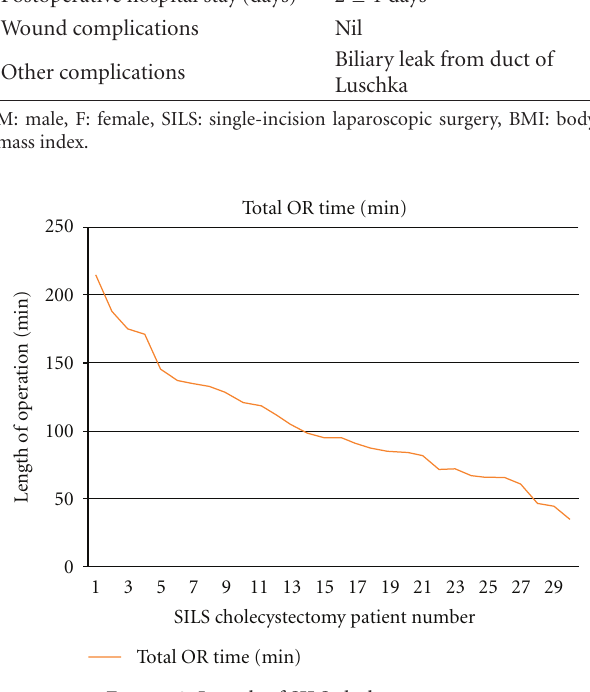
Figure 2: Length of SILS cholecystectomy.